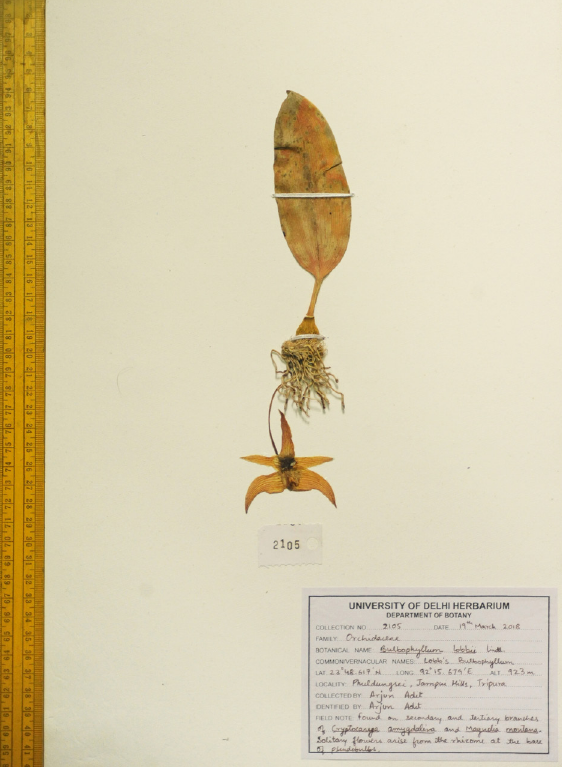
Image 11. Herbarium record of Bulbophyllum affine Wall. ex Lindl. Image 12. Herbarium record of Bulbophyllum lobbii Lindl.